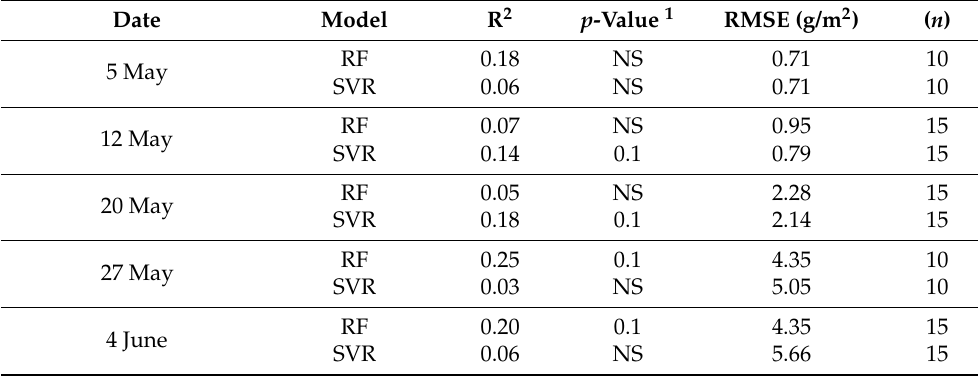
Table 6. Statistics for the validation of the UAV canopy nitrogen models with 28 variables as a function of the date and modelling approach (RF or